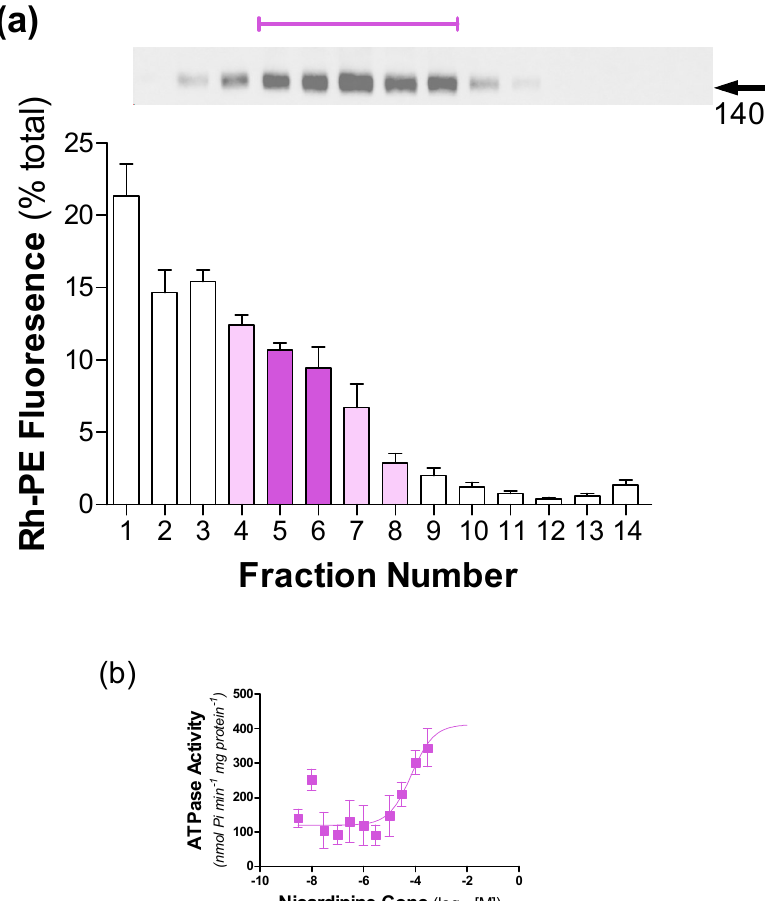
Figure 8. E ff ectiveness of reconstituting P-gp into hybrid polymersomes that were destabilised by TX-100. P-gp was reconstituted into hybrid vesicles containing 50 mol% of each of PBd-PEO and EcCL using detergent (TX-100) adsorption. The vesicles also contained a small proportion (0.1 mol %) of the lipid probe Rh-PE. ( a ) The presence of Rh-PE fluorescence ( λ ex = 560 ± 5 nm and λ em = 583 ± 5 nm) was monitored in each fraction collected from the sucrose gradient. The presence of P-gp was detected in each fraction of the gradient using Western immuno-blotting with an anti-His antibody. The protein fractions ( upper panel ) were placed above their respective position within the sucrose gradient. ( b ) The substrate stimulated ATPase activity was measured following reconstitution of P-gp. ATPase activity was measured in the presence of a fixed amount of ATP (2 mM) and at varying concentrations (10 − 9 –10 − 4 M) of Nicardipine. Values represent the mean ± SEM obtained from three independent preparations and data were fitted by non-linear regression of the general dose-response Equation (2).